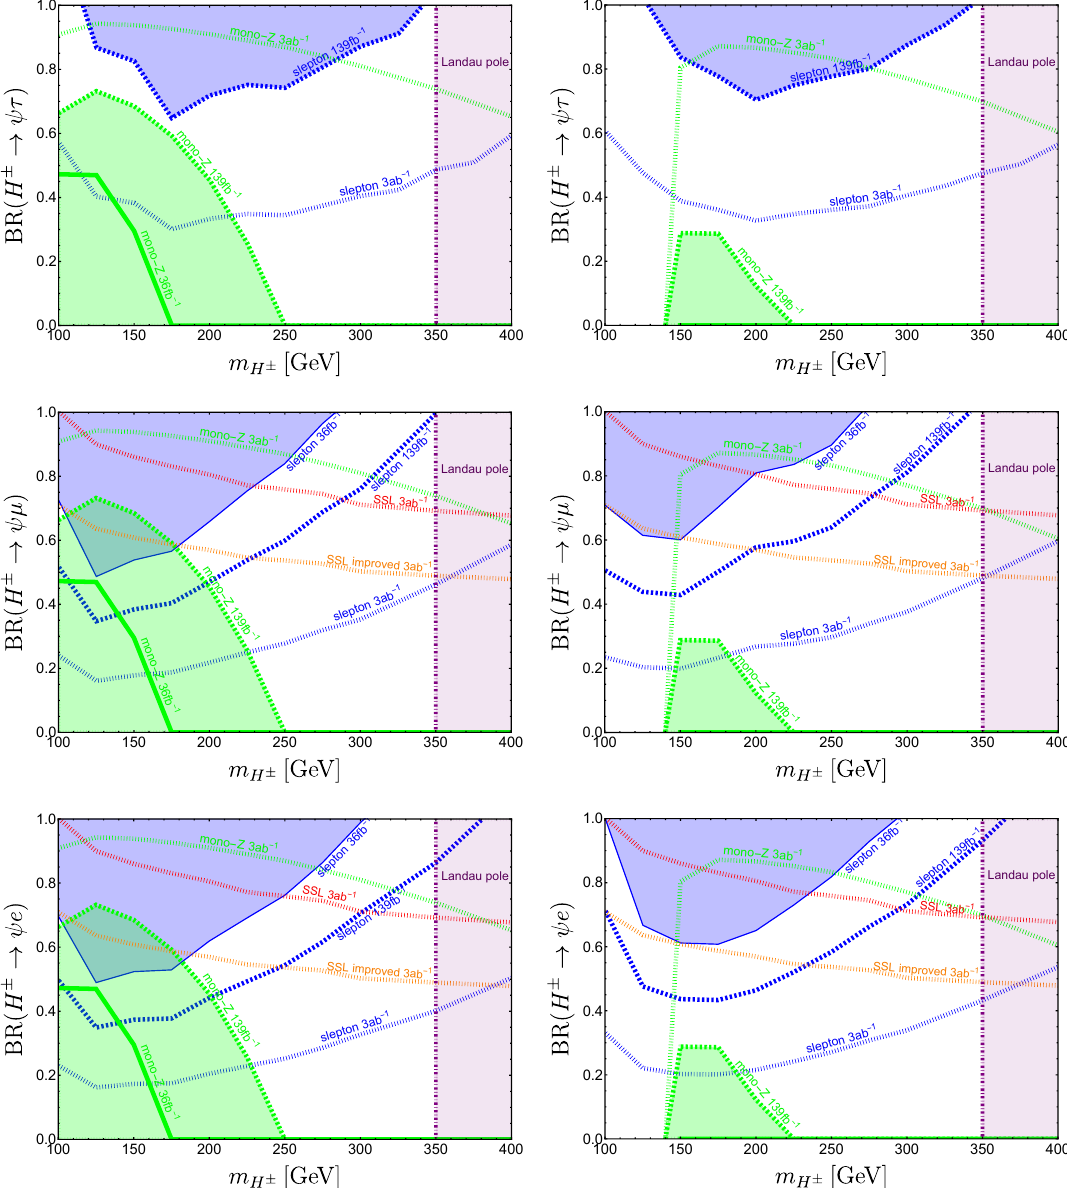
) with ( m ) = ( 1 GeV, 1 GeV) Figure 5 . The current collider constraints on BR( H ± → ψ‘ ± H , m ψ i (left panels) and ( m ) = ( 50 GeV, 10 GeV) (right panels). The plots correspond to the tauphilic, H , m ψ muonphilic and electrophilic cases from top to bottom. The solid, dashed and dotted lines represent the current constraints or the expected sensitivities for the corresponding searches with the luminosity of 36 fb − 1 , 139 fb − 1 and 3 ab − 1 , respectively. The blue regions are excluded by the slepton searches, while the green regions by the mono- Z search. Note that the mono- Z bounds are model-dependent and applicable only to the minimal model. The purple regions are excluded by the perturbativity requirement in the minimal